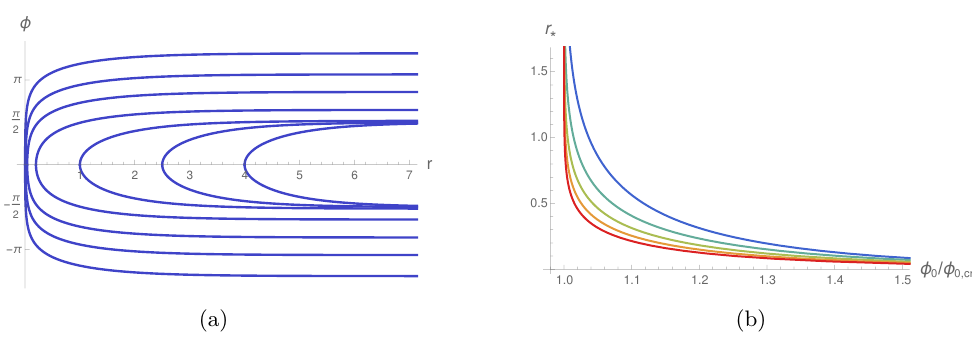
Figure 4 . Left: island surfaces for d = 2 with r h = 0 . The surfaces reach beyond φ 0 , crit = π/ 2 . As r ? moves to the UV, the surfaces approach the zero temperature surface. Right: turning point r ? as function of φ 0 with r h = 0 ; the curves are for d = 2 , 3 , 4 , 5 , 6 from bottom to top. The turning point diverges for φ 0 → φ 0 , crit